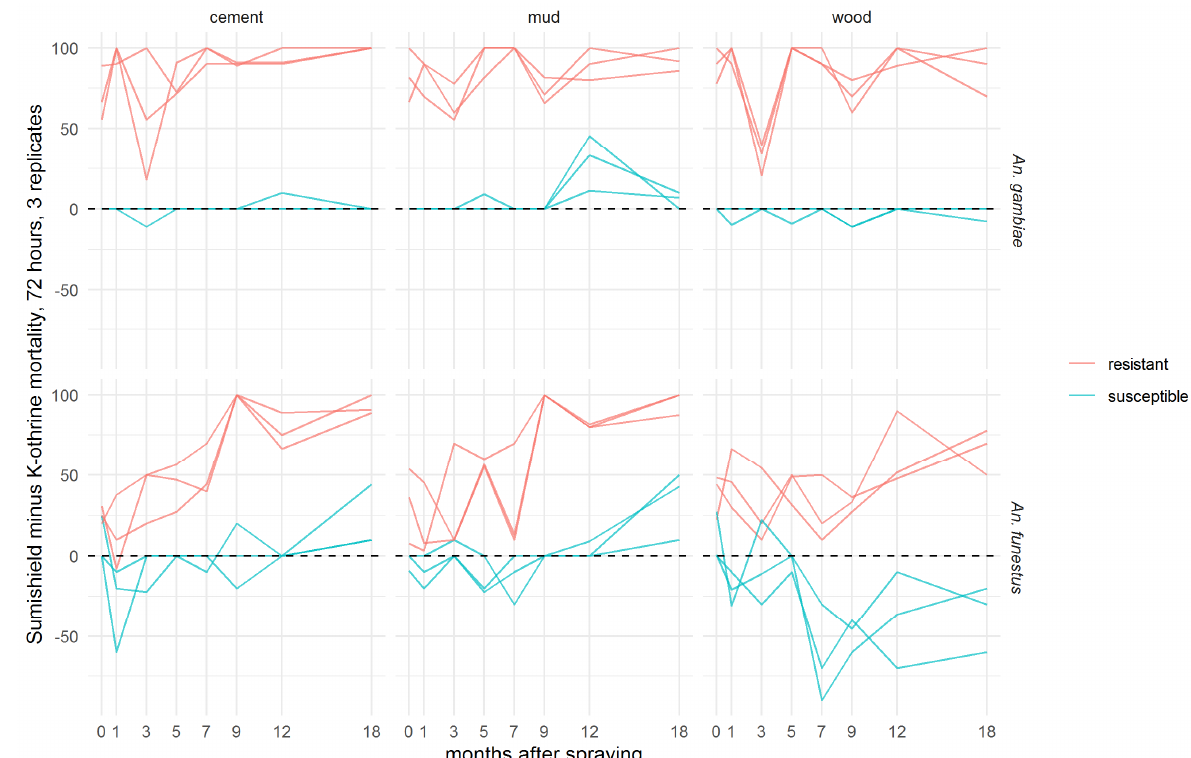
Figure 3. Efficacy of SumiShield TM 50WG compared directly with K-Othrine ® WG250 against Anopheles mosquitoes. Values represent the additional kill observed over time with clothianidin when testing resistant mosquitoes compared to susceptible mosquitoes. Here, the mortality of mosquitoes from insecticide-susceptible and -resistant strains of An. gambiae and An. funestus observed 72 h after exposure to cement, mud, or wood surfaces treated with deltamethrin IRS was subtracted from the mortality observed after exposure to clothianidin IRS. Mosquitoes were exposed in a WHO cone bioassay 24 h, 1, 3, 5, 7, 9, 12, and 18 months after treatment. Data from 3 replicates of each treatment and surface type are presented separately.